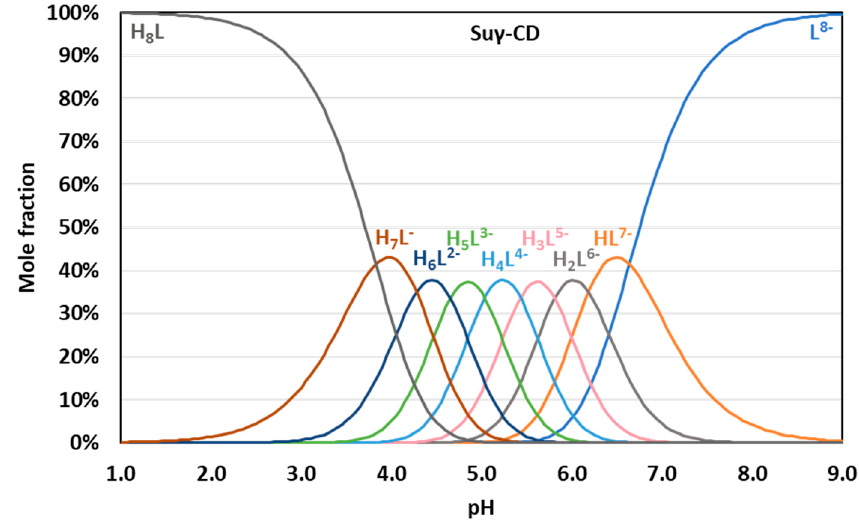
Figure 7. pH-dependent distribution of protonation microspecies of Su γ -CD.